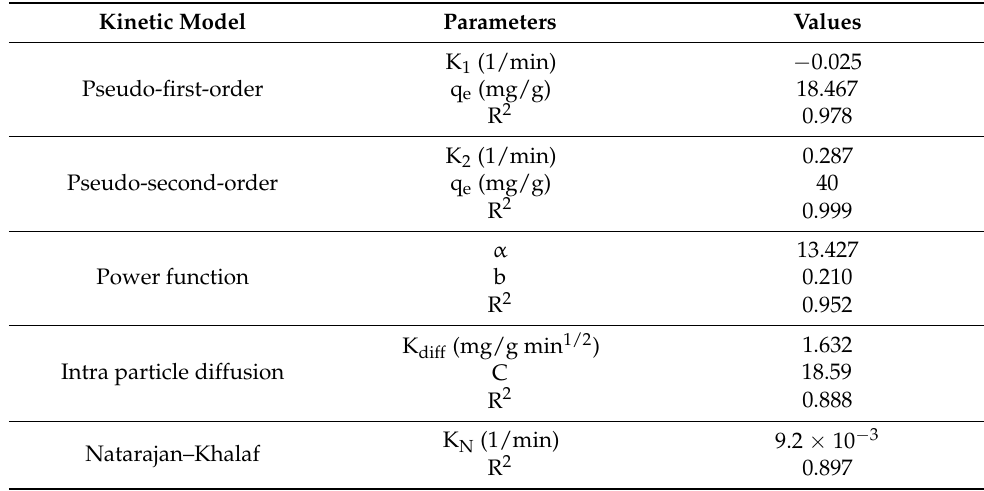
Table 3. Kinetic parameters for Cr (VI) biosorption on CMPVL.